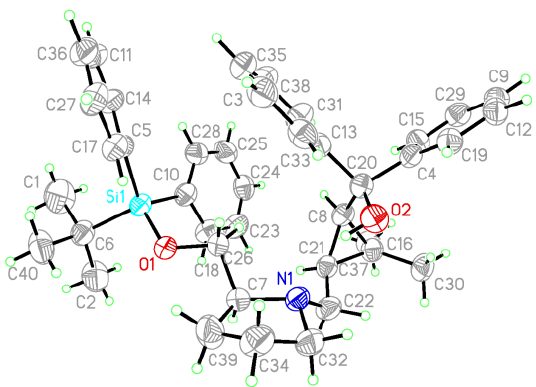
Figure 3. X-ray crystallographic structure of ligand 7e